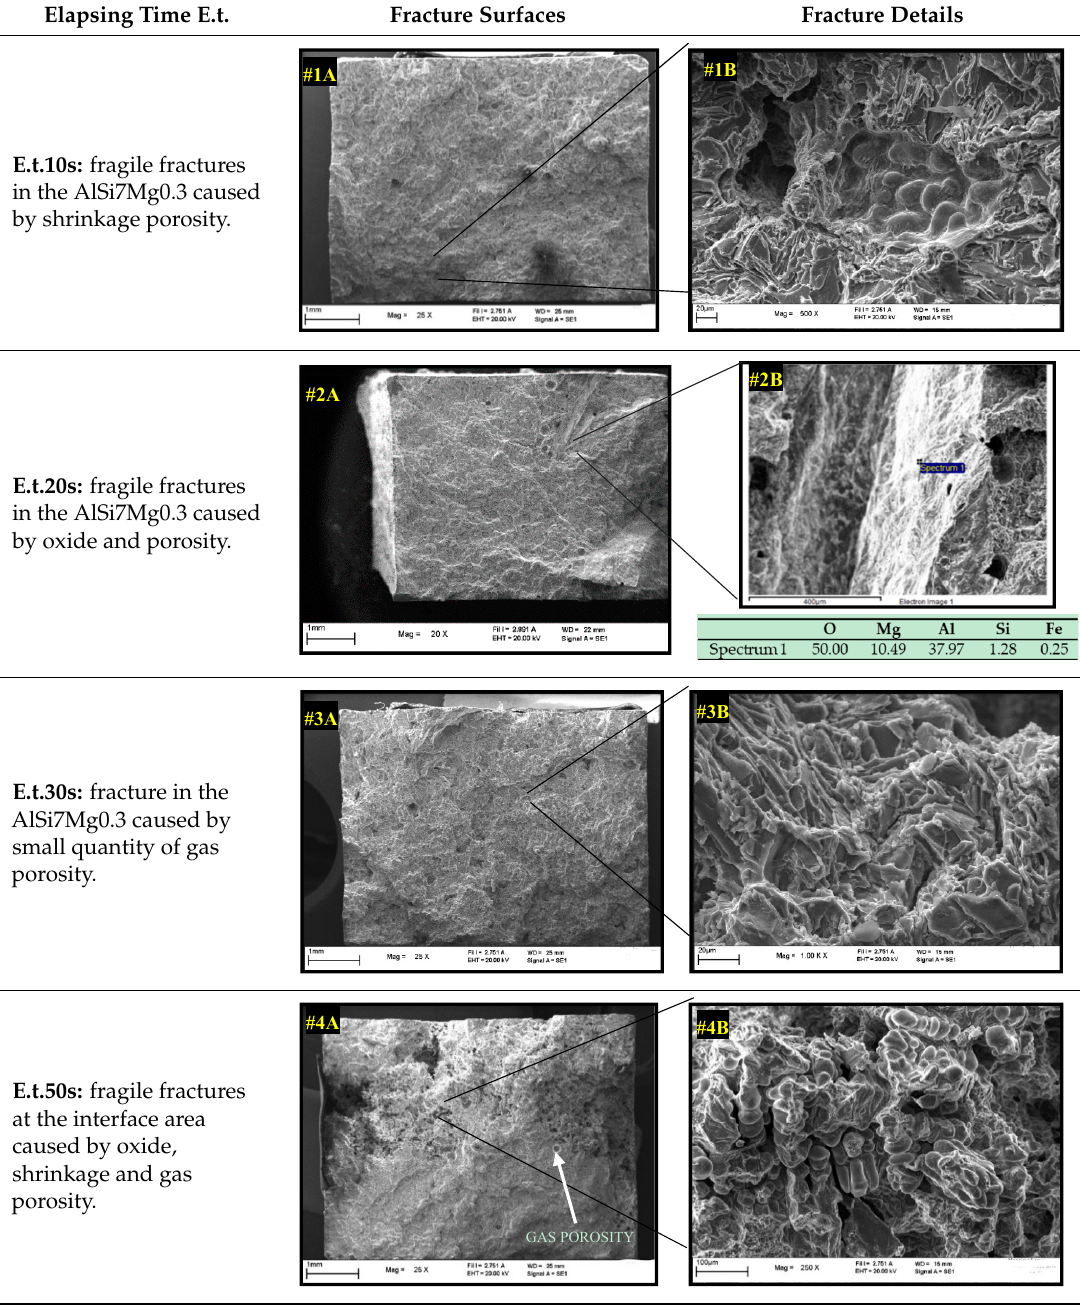
Table 3. Surface fractures for each elapsing time.